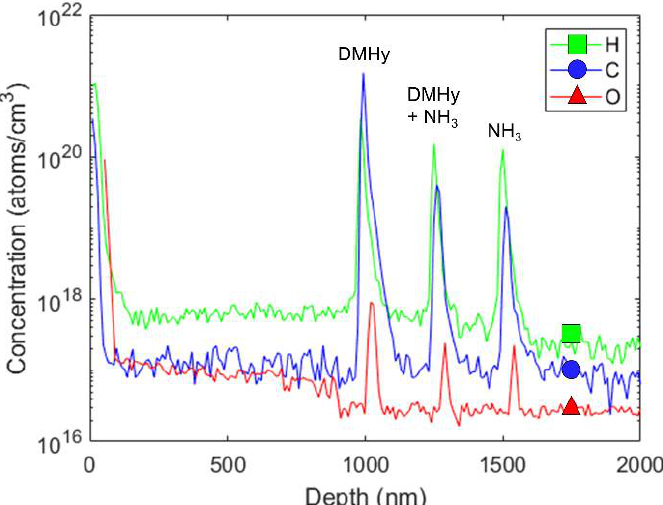
Figure 3. Hydrogen, carbon, and oxygen content in LT GaN layers determined by SIMS. The LT layers were grown continuously at 550 °C with varying N-precursors, from right to left: (S1) 135 mmol/min NH 3 , (S2) 135 mmol/min NH 3 and 3.9 mmol/min DMHy, (S3) 3.9 mmol/min DMHy. Table 2. Impurity concentrations (C, O) in LT GaN layers with varying N-precursors, determined from SIMS measurements. Layer